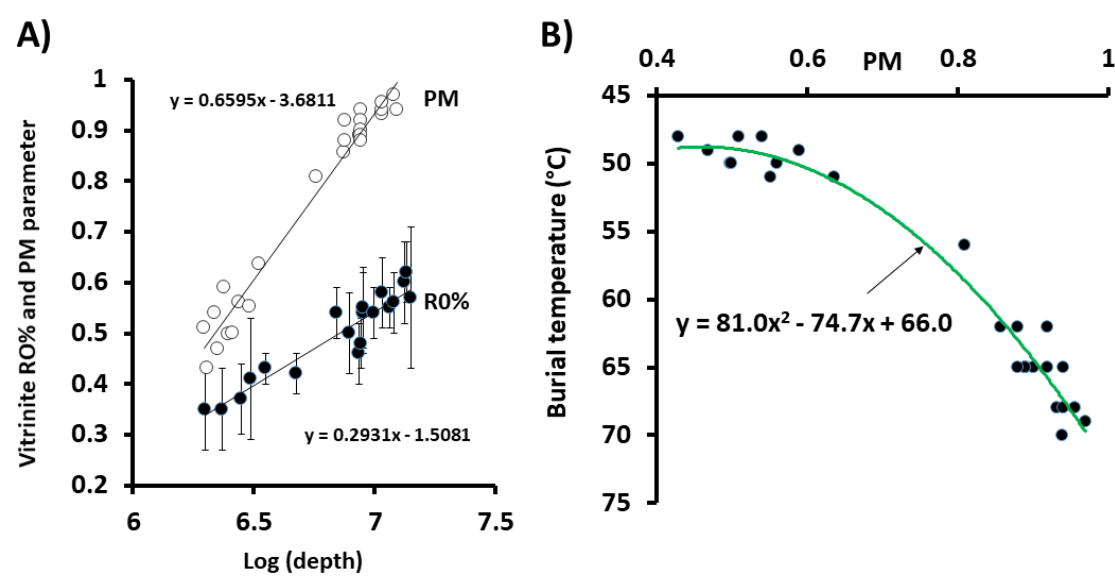
Figure 13. ( A ) Vitrinite reflectance data RO% (with standard deviation at one sigma) and PM magnetic parameter as a function of depth (m). Note the log scale of depth. ( B ) PM magnetic parameter for EST433 samples with CaCO 3 < 60% as a function of burial temperature, as proposed by Blaise et al. [8]. The PM instrumental uncertainty was below 1%. Best fittings were calculated for curves.